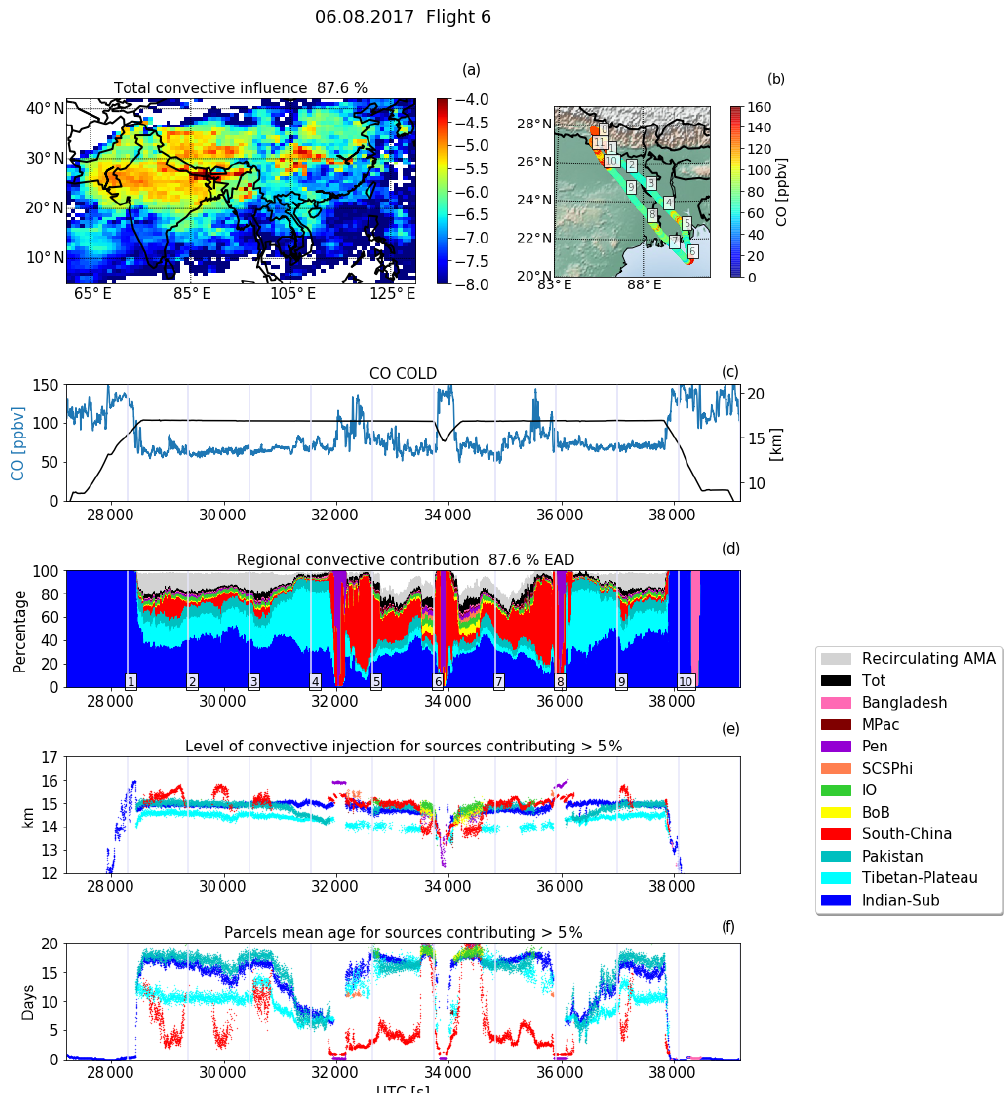
Figure 7. Back trajectory analysis of convective sources for F6 (6 August 2017). (a) Convective-source-region distribution. (b) CO con- centration along the flight track. The numbers along the flight track correspond to the numbers along the time series of panel (d) . (c) CO concentration along the path of flight (in blue) and altitude of the flight (black). (d) Convective-source contributions along the flight. The colour is referring to the region colour code of Fig. 3 plus the non-convective air recirculating inside the AMA (grey shade) and the remaining convective sources (black). (e) Level of injection for convective sources contributing 5% of the total convective air. This level is computed as the height at which the trajectory is first found below the convective cloud top. (f) Age of the convective air for convective sources con- tributing for 5% of the total convective air. The age is computed as the number of days between the trajectory release and the encountering of a convective